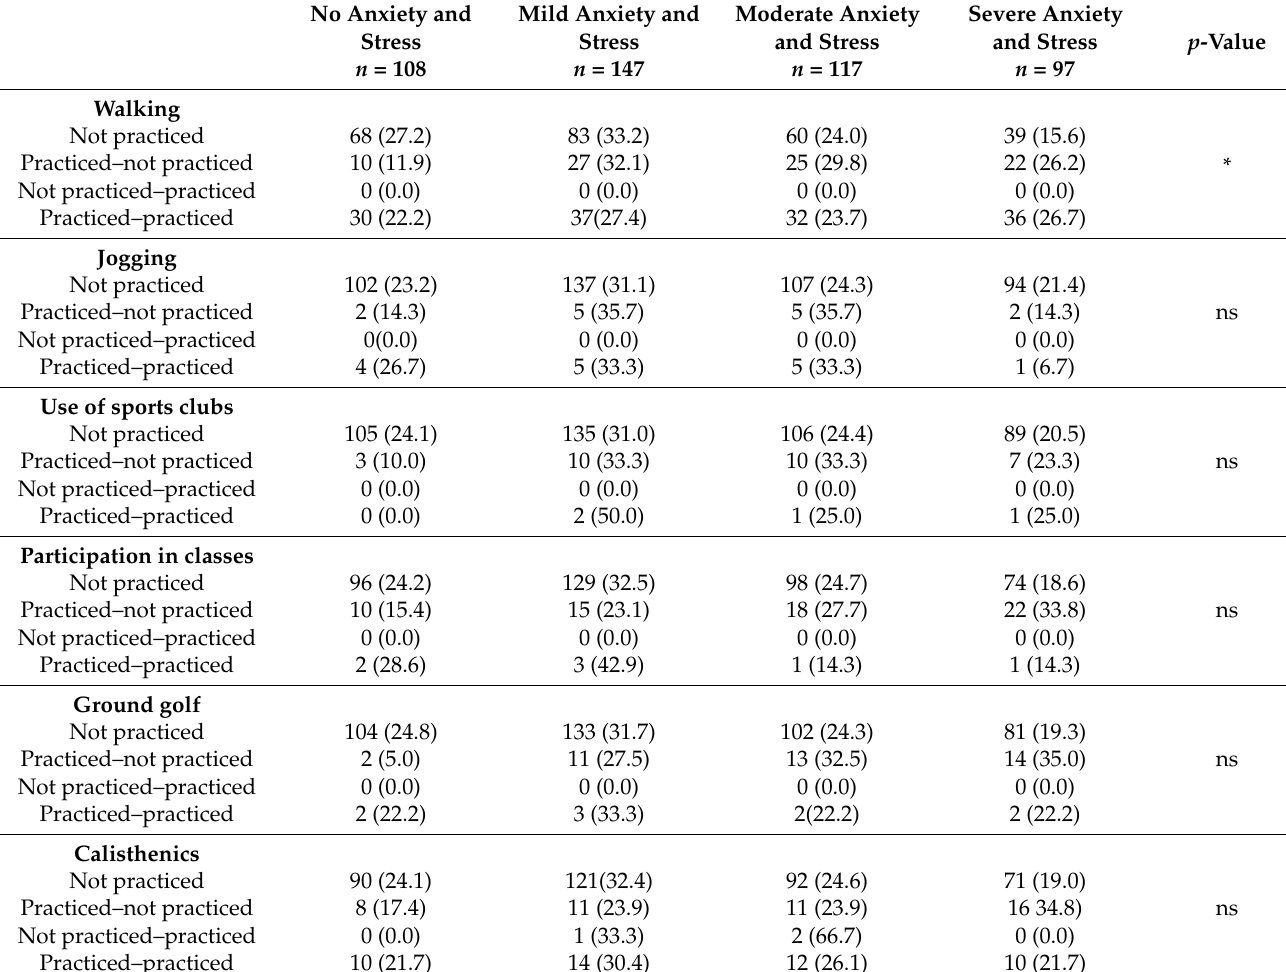
Table 6. Exercise during the COVID-19 pandemic in respondent groups with different levels of anxiety and stress. Mild Anxiety and No Anxiety and Stress Stress n = 108